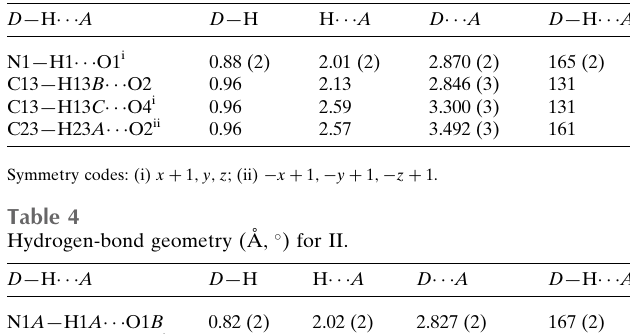
Table 3 Hydrogen-bond geometry (A˚ , (cid:2) ) for I.